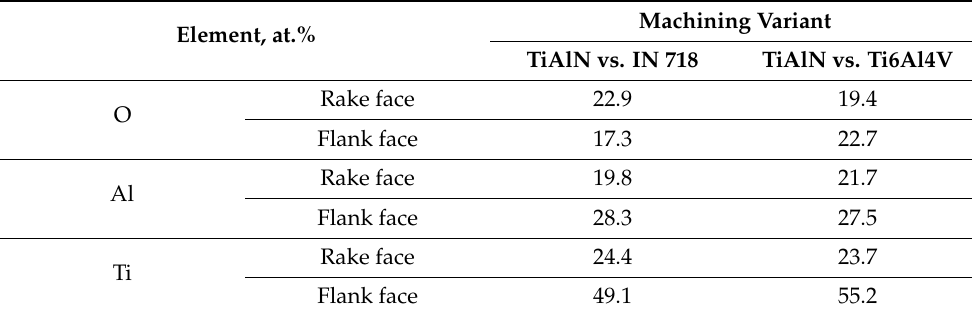
Table 4. The estimated chemical composition of oxidized layer formed in machining tests on the rake and flank faces in point # 3 in Figure 8b and point #2 in Figure 9b (data for all points are specified in Table 5). Element,